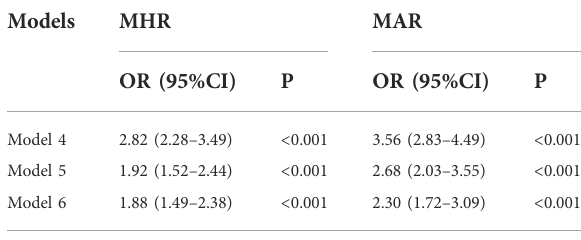
TABLE 4 Multivariate linear regression analysis of associations between MHR, MAR and bone turnover markers, bone mineral density.